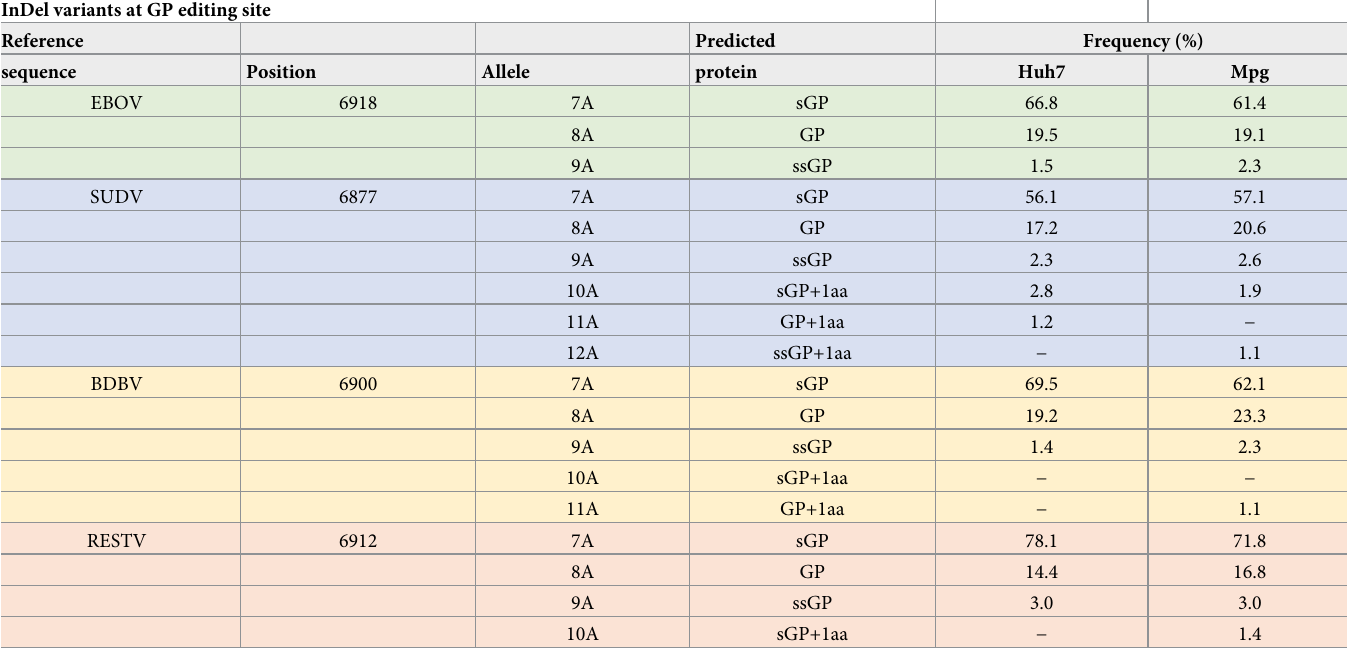
Table 1. InDel variants at the canonical GP editing site. Huh7 and Mpg cells were infected with EBOV, SUDV, BDBV, or RESTV at moi = 0.1. Total RNA was harvested 3 dpi, and purified mRNAs were used to make NGS libraries. Variant detection was done using a minimum cut-off of 1%. InDel variants at GP editing site